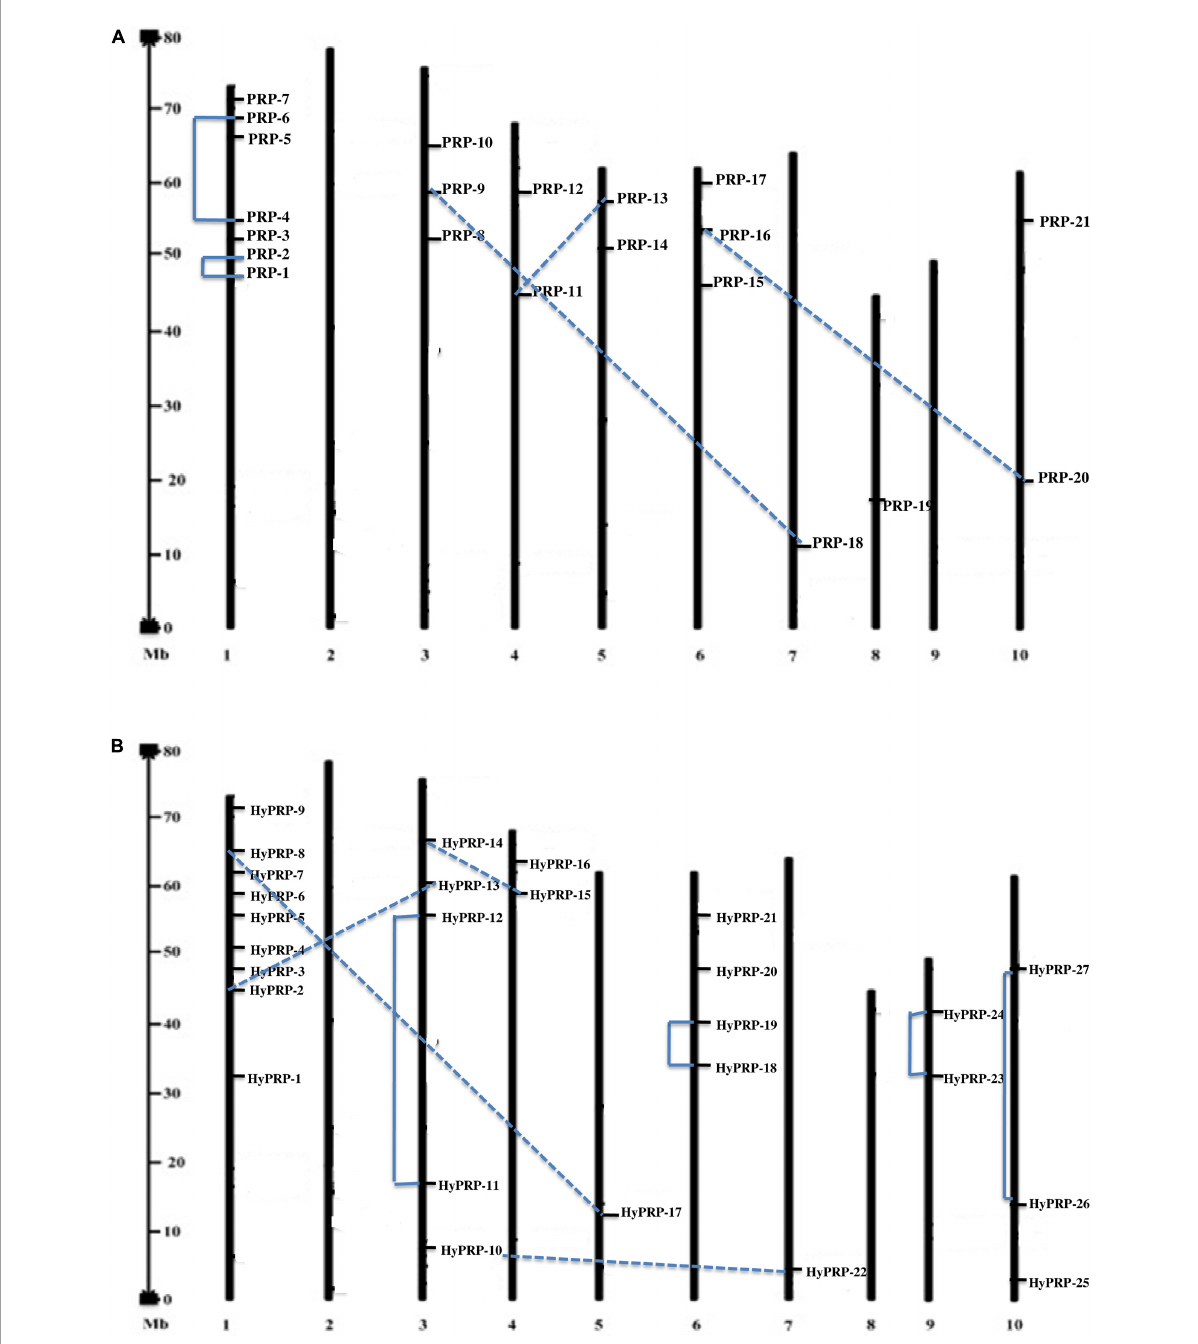
FIGURE2 Location and duplications of SbPRP and SbHyPRP. (A) Location and duplication of SbPRPs on chromosomes. (B) Location and duplication of SbHyPRPs on